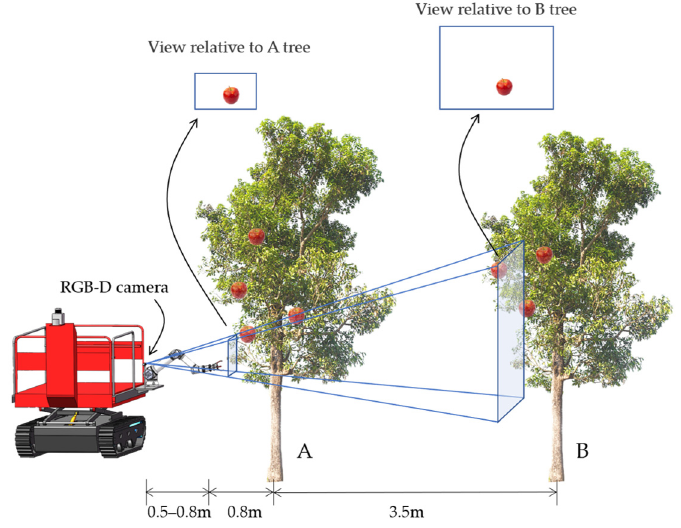
Figure 9. Diagram of apple picking robot operating environment under complex environment.